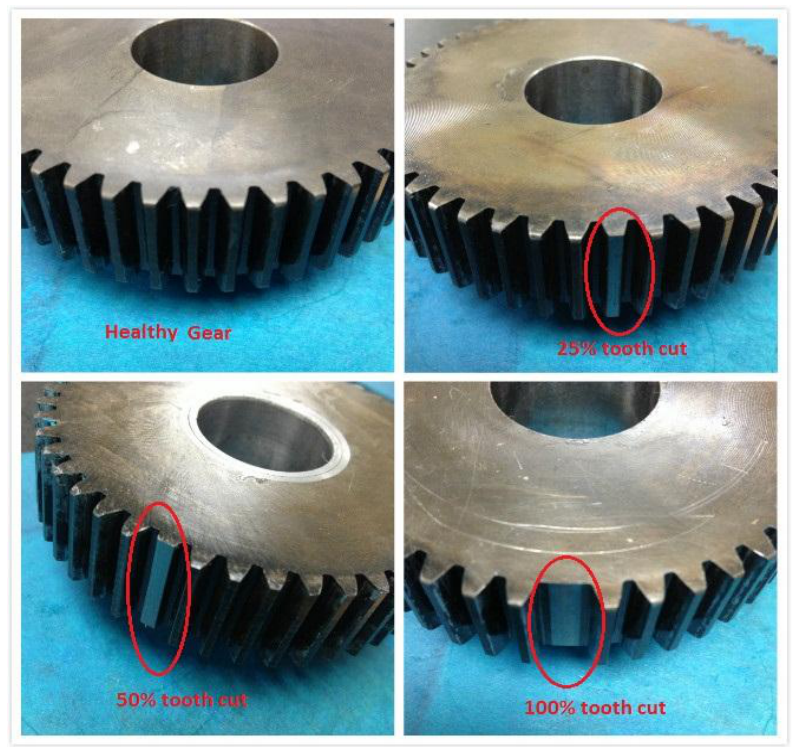
Figure 6. Seeded tooth cut